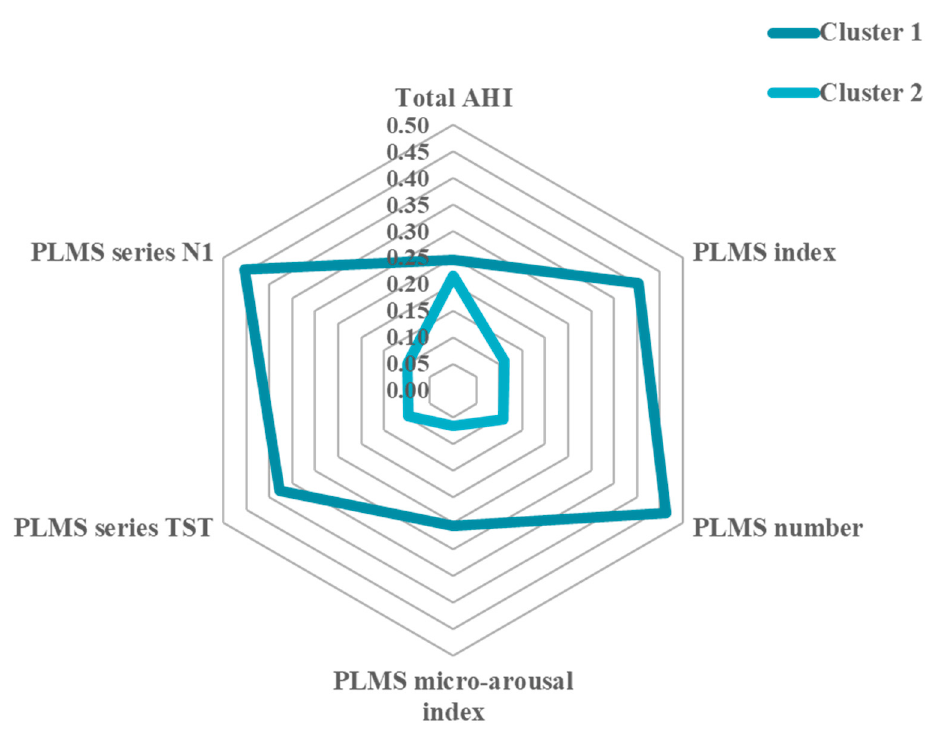
Figure 2. Normalized means of sleep parameters across clusters.